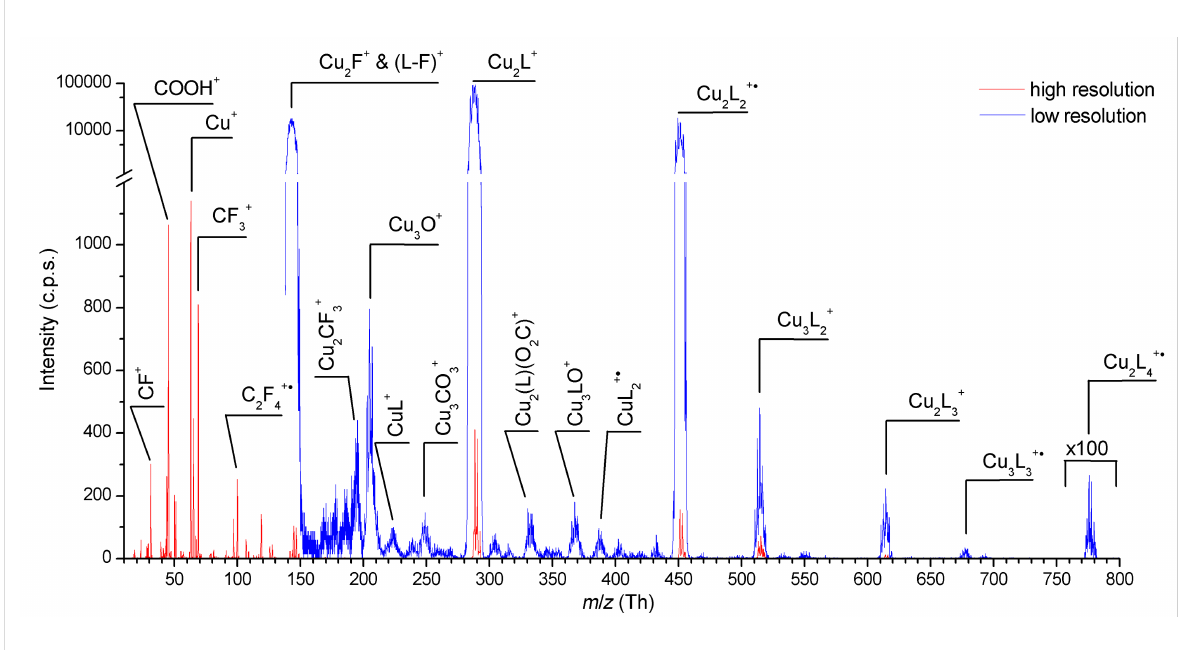
Figure 2: Mass spectrum of [Cu 2 (µ-O 2 CC 2 F 5 ) 4 ] molecule over the range m / z 10–800 obtained at electron energy 70 eV and temperature of the beam source of ≈ 150 °C. The notation L = O 2 CC 2 F 5 was used in the mass spectrum. The spectral range below m / z 150 and selected peaks at higher masses were measured with higher mass resolution (red line) while the range above m / z 150 was registered with lower resolution (blue line) to increase the signal.